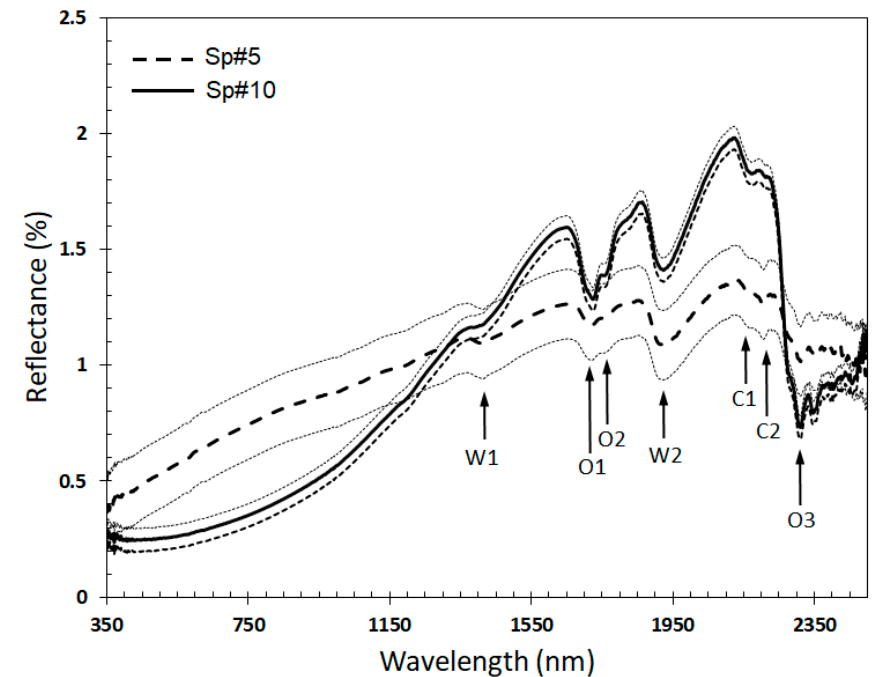
Figure 8. Average spectra for the 6 locations measured on two oil sand samples (Sp#5, Sp#10) and the standard deviation envelope displayed by grey lines about the mean spectra shown in black.